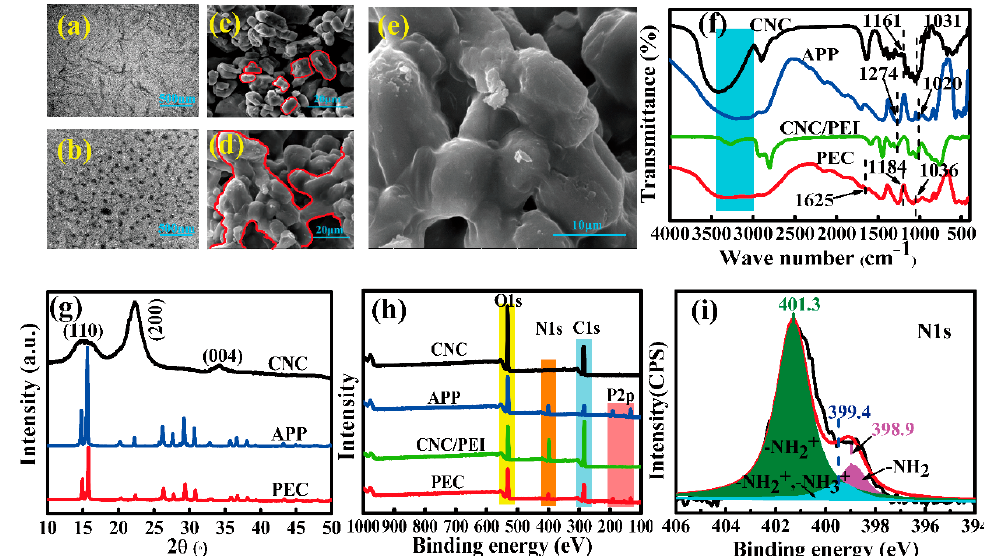
Figure 2. Morphological and physicochemical characterization of PEC. TEM of CNC ( a ) and APP ( b ), SEM of APP ( c ), PEC (2000 × , d ), and PEC (4000 × , e ), FTIR ( f ), XRD ( g ), XPS ( h ) spectra of PEC, and its N1s high-resolution spectra of PEC ( i ).